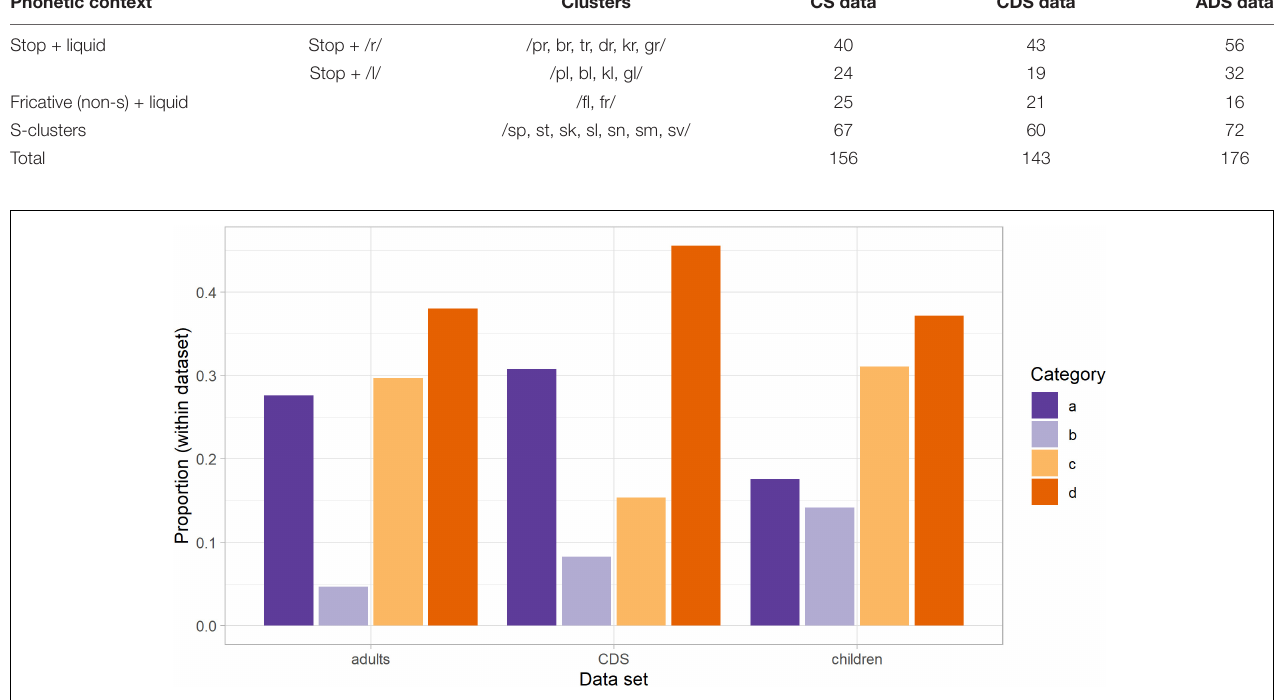
FIGURE 1 | Distributions of the four categories of intrusion across the three